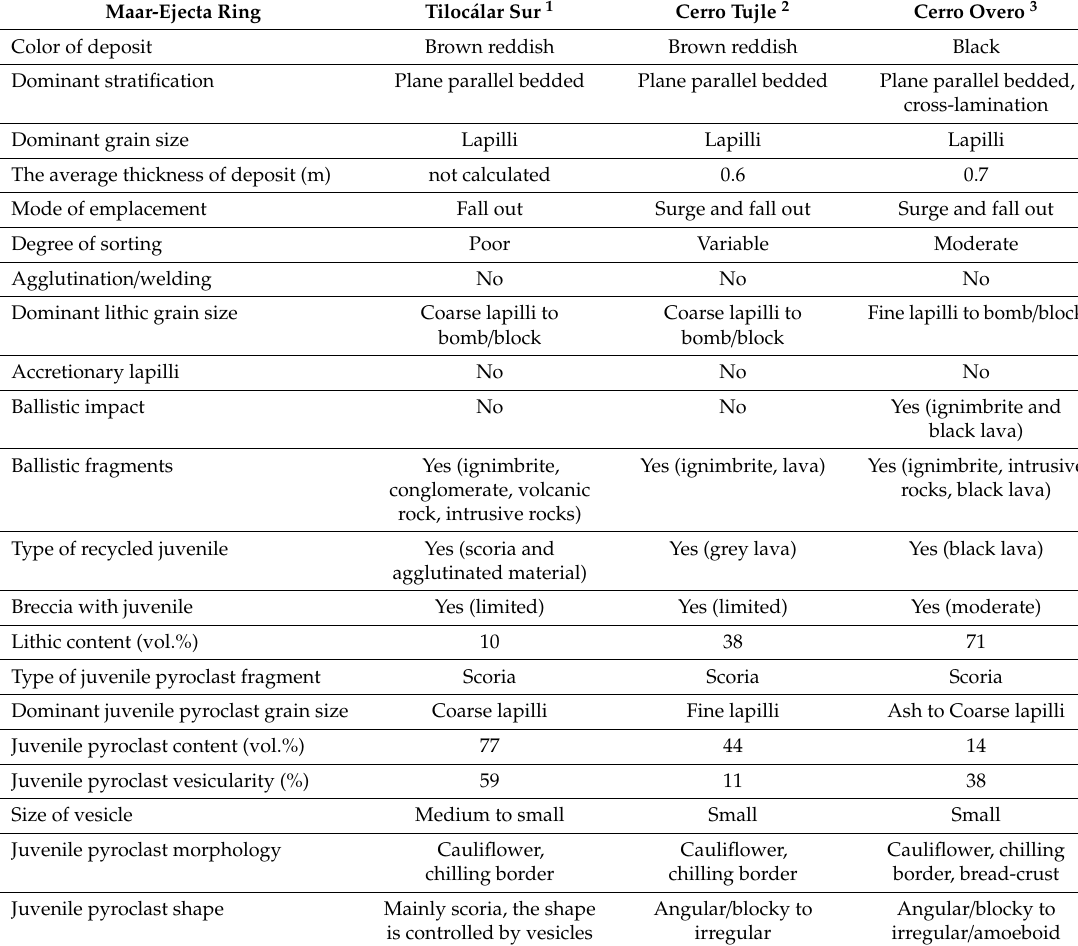
Table 3. Deposit features of Tiloc á lar Sur, Cerro Tujle, and Cerro Overo